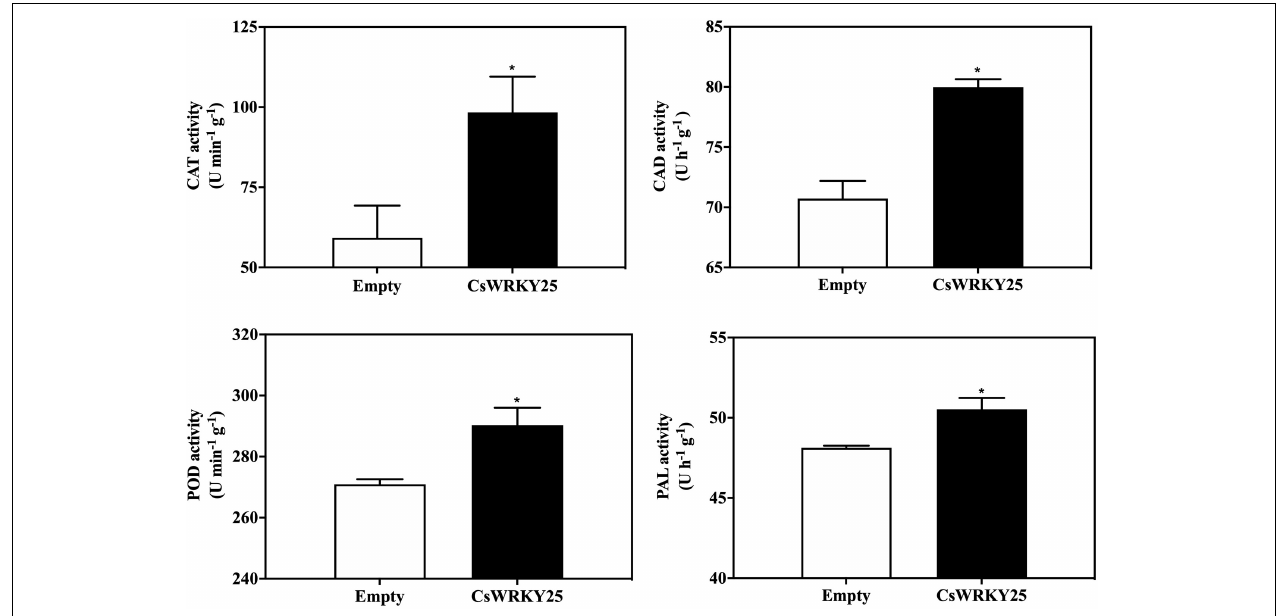
FIGURE 7 | Catalase (CAT), cinnamyl alcohol dehydrogenase (CAD), phenylalanine ammonia-lyase (PAL), and peroxidase (POD) activities in pEAQ and CsWRKY25 overexpressed citrus fruit peel. Enzymatic activities are expressed on a fresh weight basis. P values were regarded as statistically significant at * P <